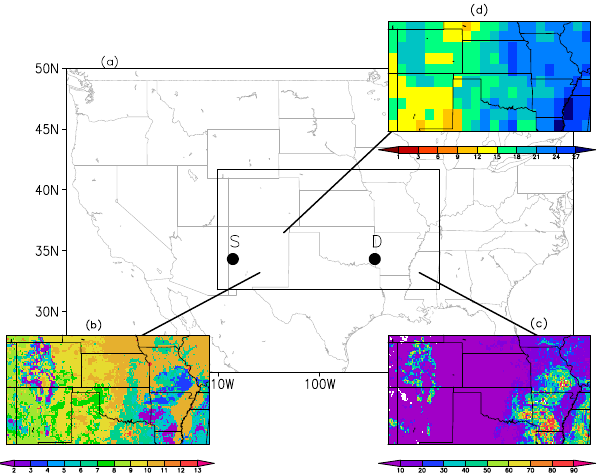
Fig. 1. (a) Simulation domain denoted by inner black box, (b) land cover category, (c) time-averaged vegetation water con- Fig.1. (a)Simulationdomaindenotedbyinnerblackbox,(b)landcovercategory,(c)timeaveragedvegetation tent (kgm − 2 ) from October 2002 to September 2003 and (d) time- watercontent(kg/m 2 )fromOctober2002toSeptember2003and(d)timeaveragedsoilmoisture(%vol/vol) averaged soil moisture (% vol/vol) truth during September 2002 to truthduringSeptember2002toSeptember2003. Blackdotsrepresentsparsely(S)anddensely(D)vegetated pixels. September 2003. Black dots represent sparsely (S) and densely (D) vegetated